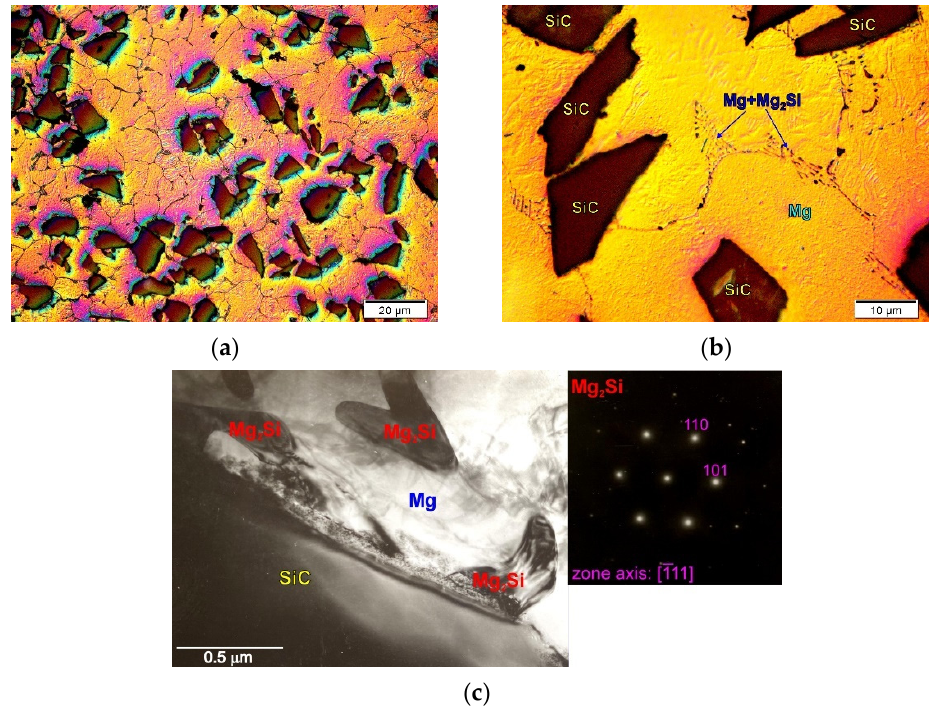
Figure 3. Microstructure of magnesium matrix composites with SiC particles. ( a , b ) Micrographs taken at different magnification; ( c ) TEM micrograph of interface between components with diffraction pattern from observed Mg 2 Si phase.